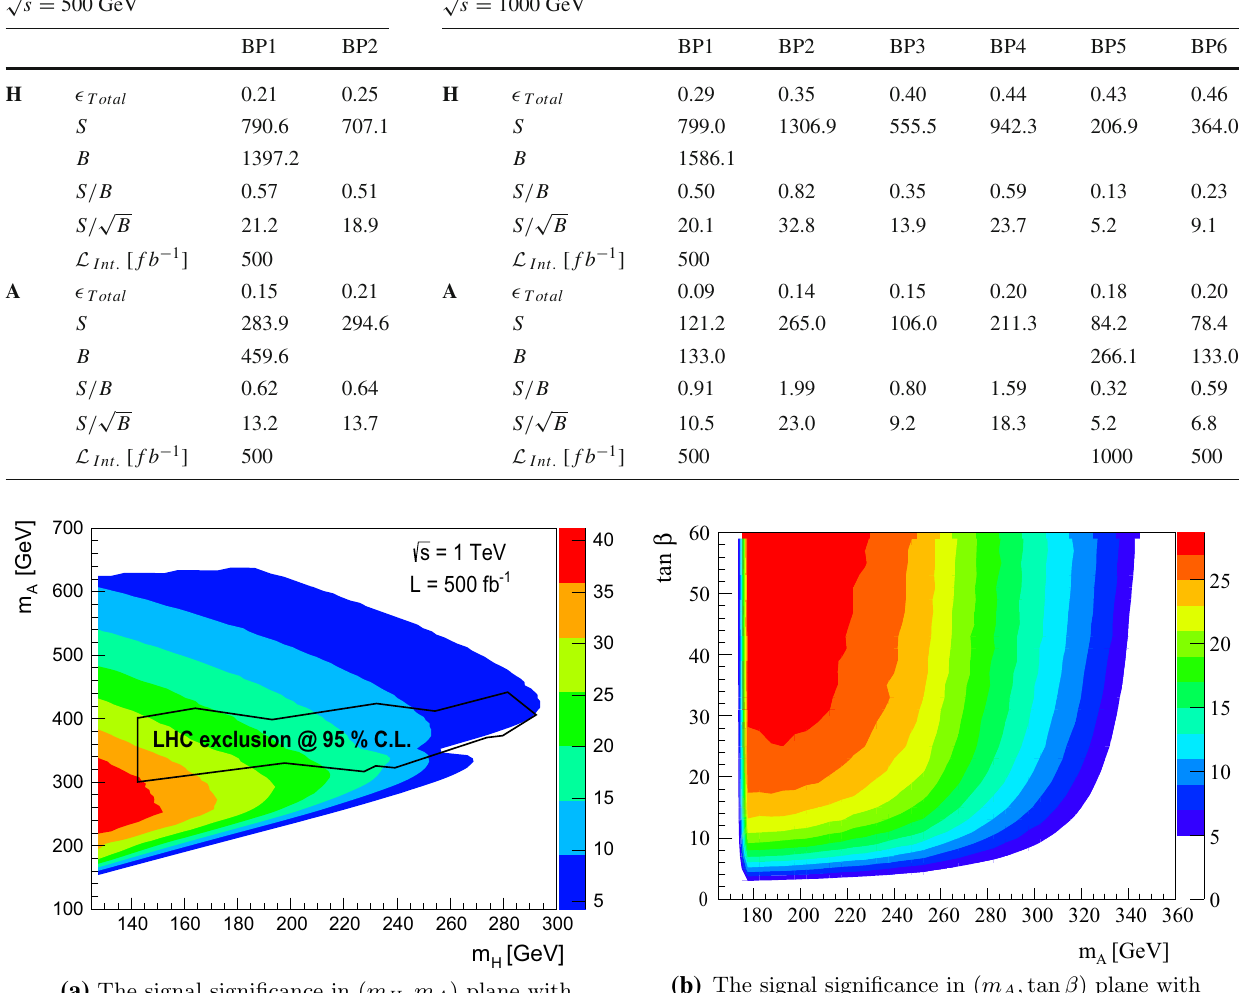
Table 8 Total signal selection efficiency ( (cid:14) Total ), number of signal (S) and background (B) candidate masses, signal to background ratio, signal significance and the assumed integrated luminosity in different scenarios at the center-of-mass energies of (a) 500 and (b) 1000 GeV √ s = 500 GeV